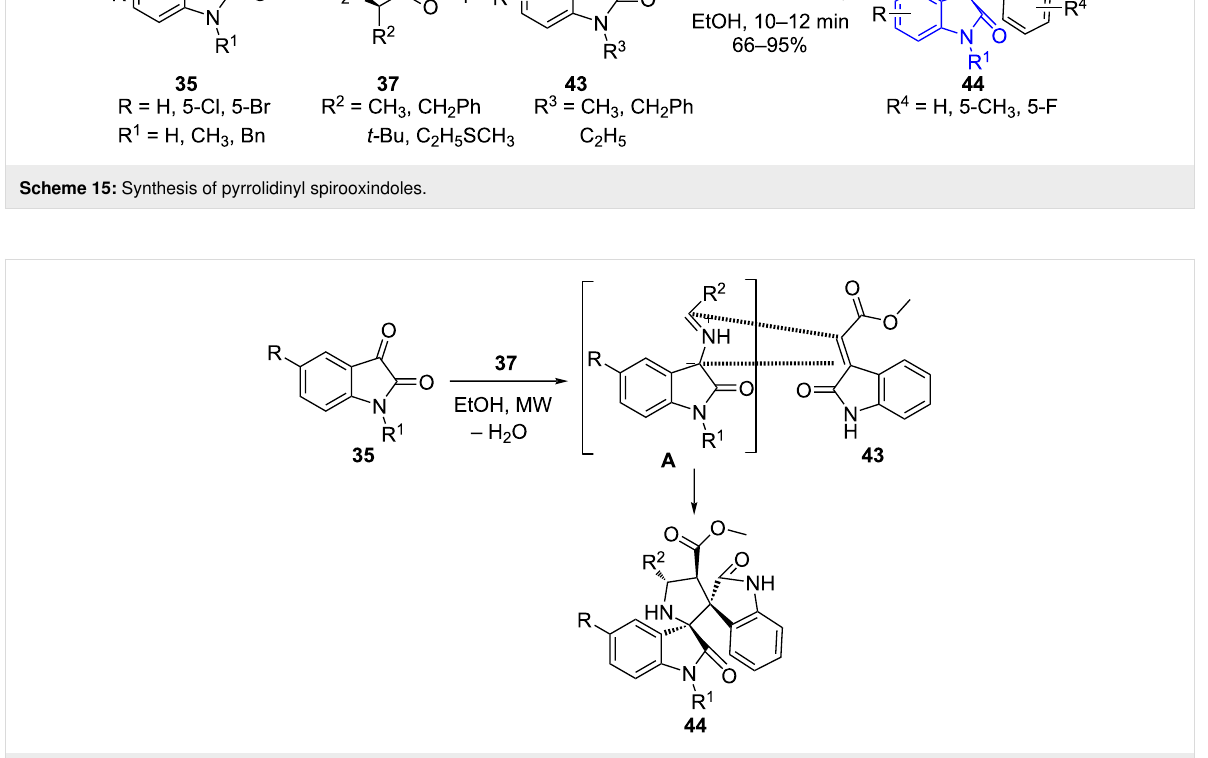
Scheme 16: Proposed mechanism for pyrrolidinyl